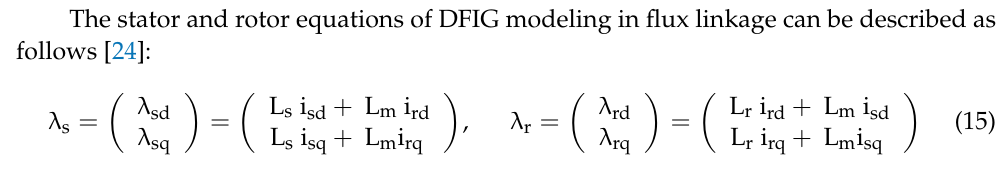
Figure 9. Equivalent circuit for the DFIG in d-q reference frame, ( a ) d-axis model, and ( b ) q-axis model.